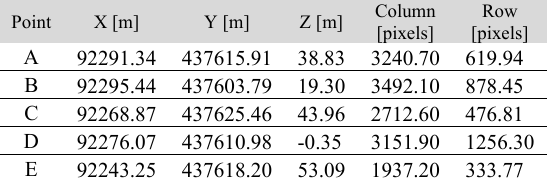
Table 3. Five control points of the second test.